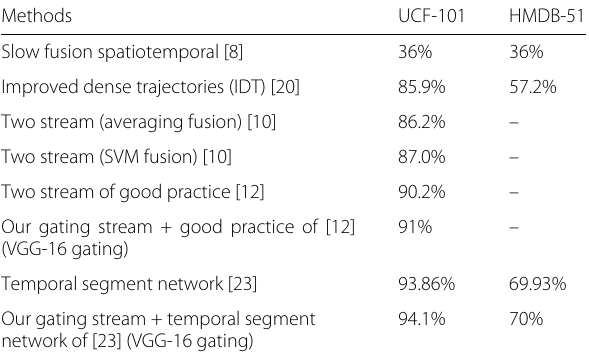
Table 11 HMDB-51 (split 1) Methods